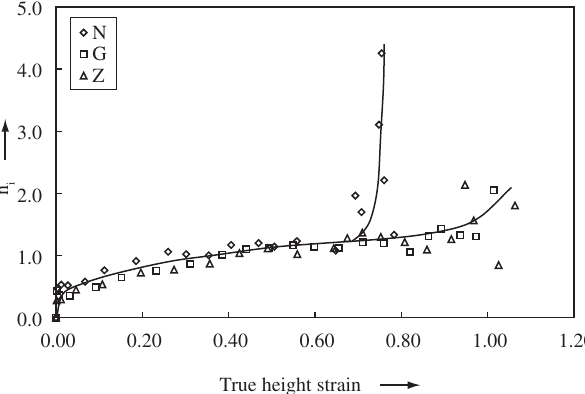
Figure 6. Relationship between instantaneous strain hardening exponent (n and true height strain.